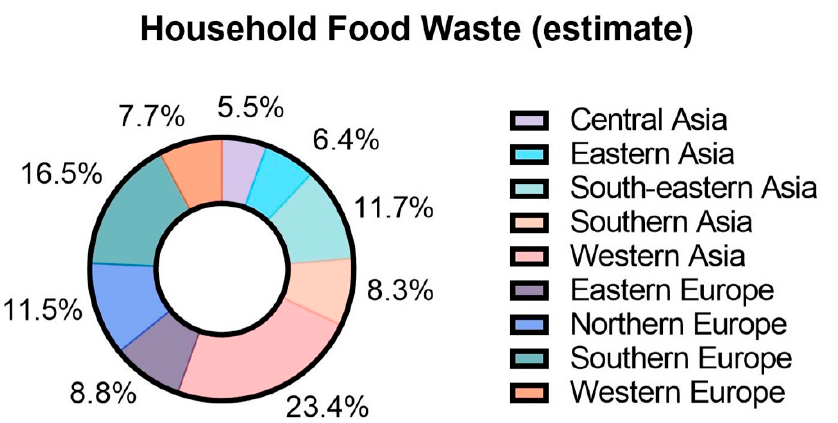
Figure 3. Household food waste in Asia and Europe countries published in Food Waste Index Report 2021 [27].